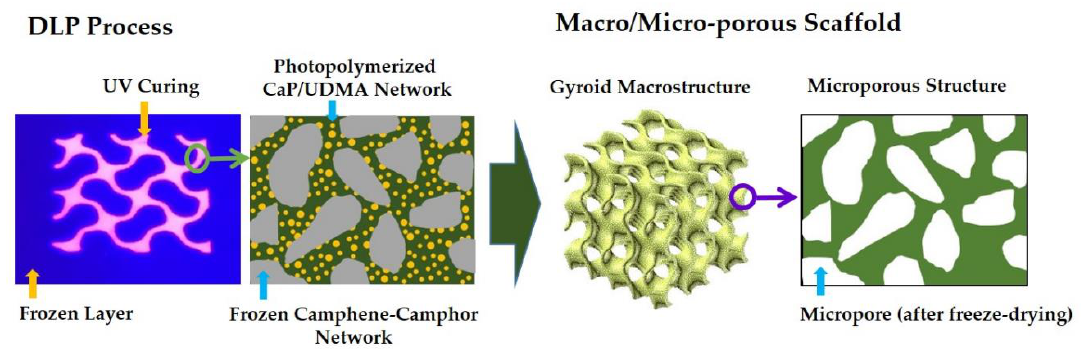
Figure 1. Schematic diagram showing the manufacturing of a macroporous calcium phosphate (CaP) scaffold with a gyroid macrostructure comprised of microporous frameworks using our recently developed DLP technique. Micropores can be created by removing the camphene-camphor network through freeze-drying.